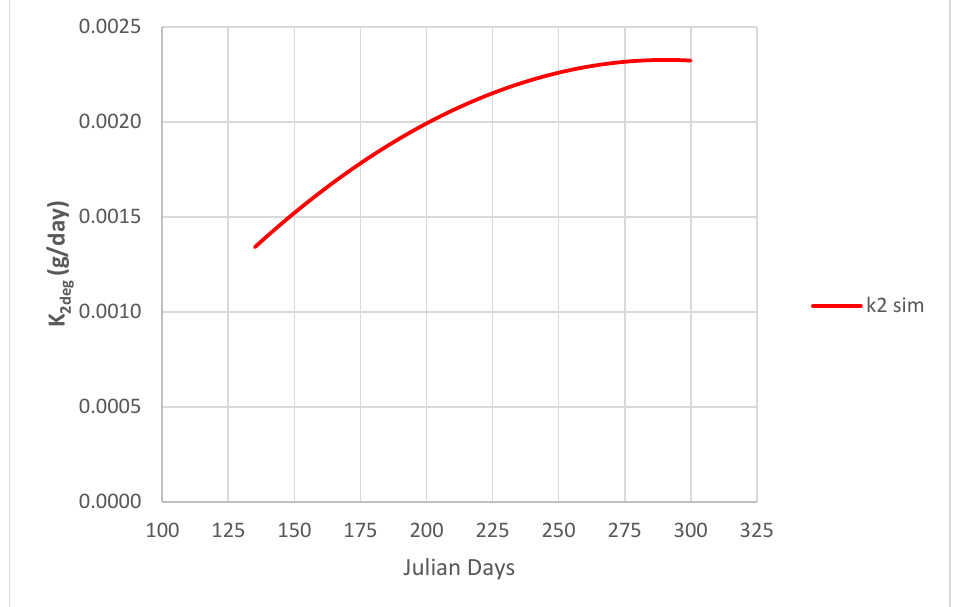
Figure 5. Simulated k 2acc (t) values obtained by Equation (10) (continuous line in red), and the observed ones obtained by Equation (8) (points in blue).